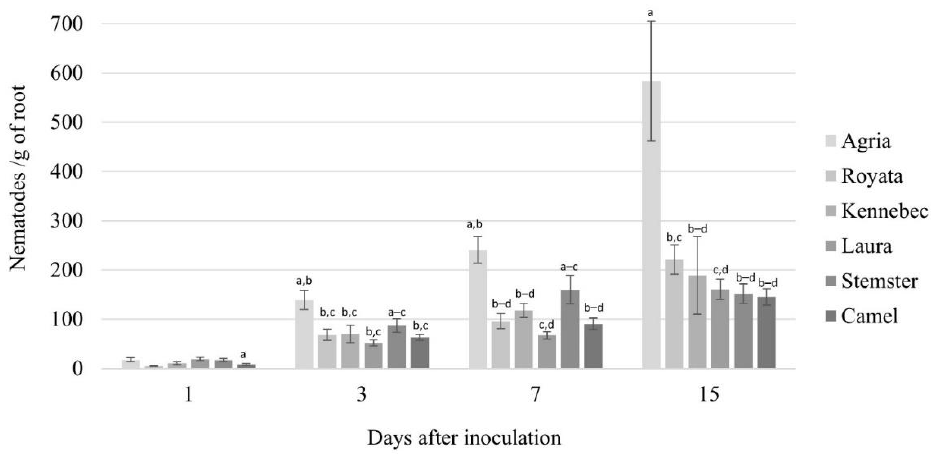
Figure 2. Pratylenchus penetrans /g of root in potato cultivars Agria, Royata, Kennebec, Laura, Stemster, and Camel at 1, 3, 7, and 15 days after inoculation with 750 P. penetrans mixed stages/plant. Data are the means of eight replicates ± SE. Means followed by a different combination of letters differ significantly at p < 0.05, according to the Fisher LSD test.